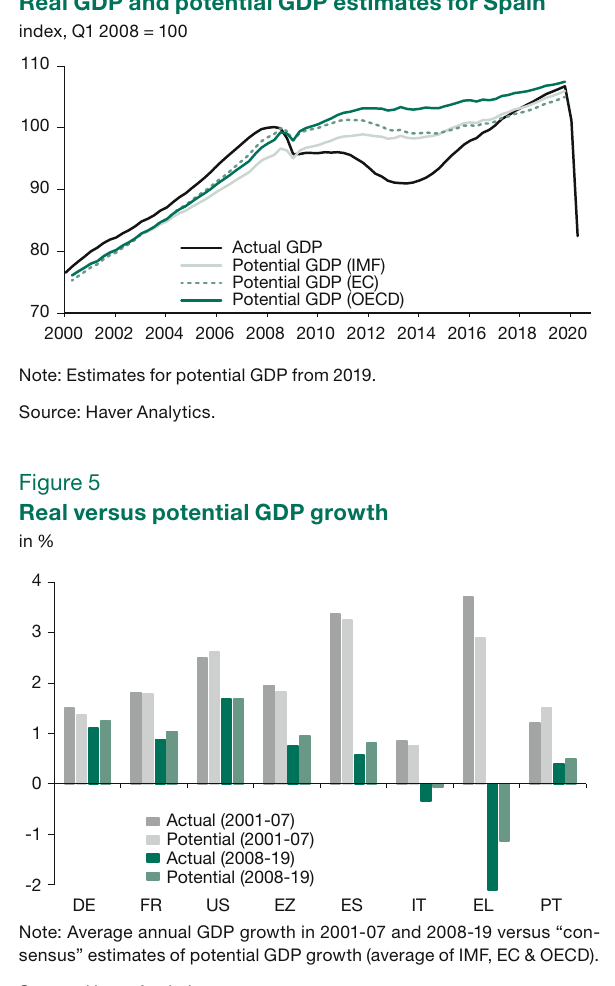
Real GDP and potential GDP estimates for Spain Real GDP and potential GDP estimates for Italy index, Q1 2008 = 100